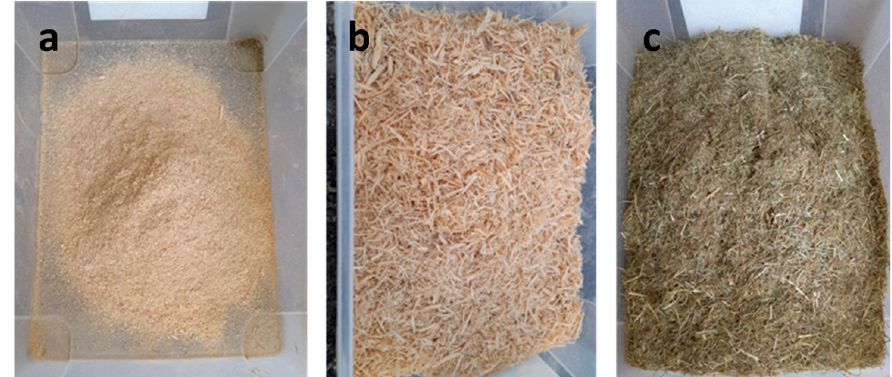
Figure A2. ( a ) Sawdust; ( b ) Wood chips; ( c ) Hay.